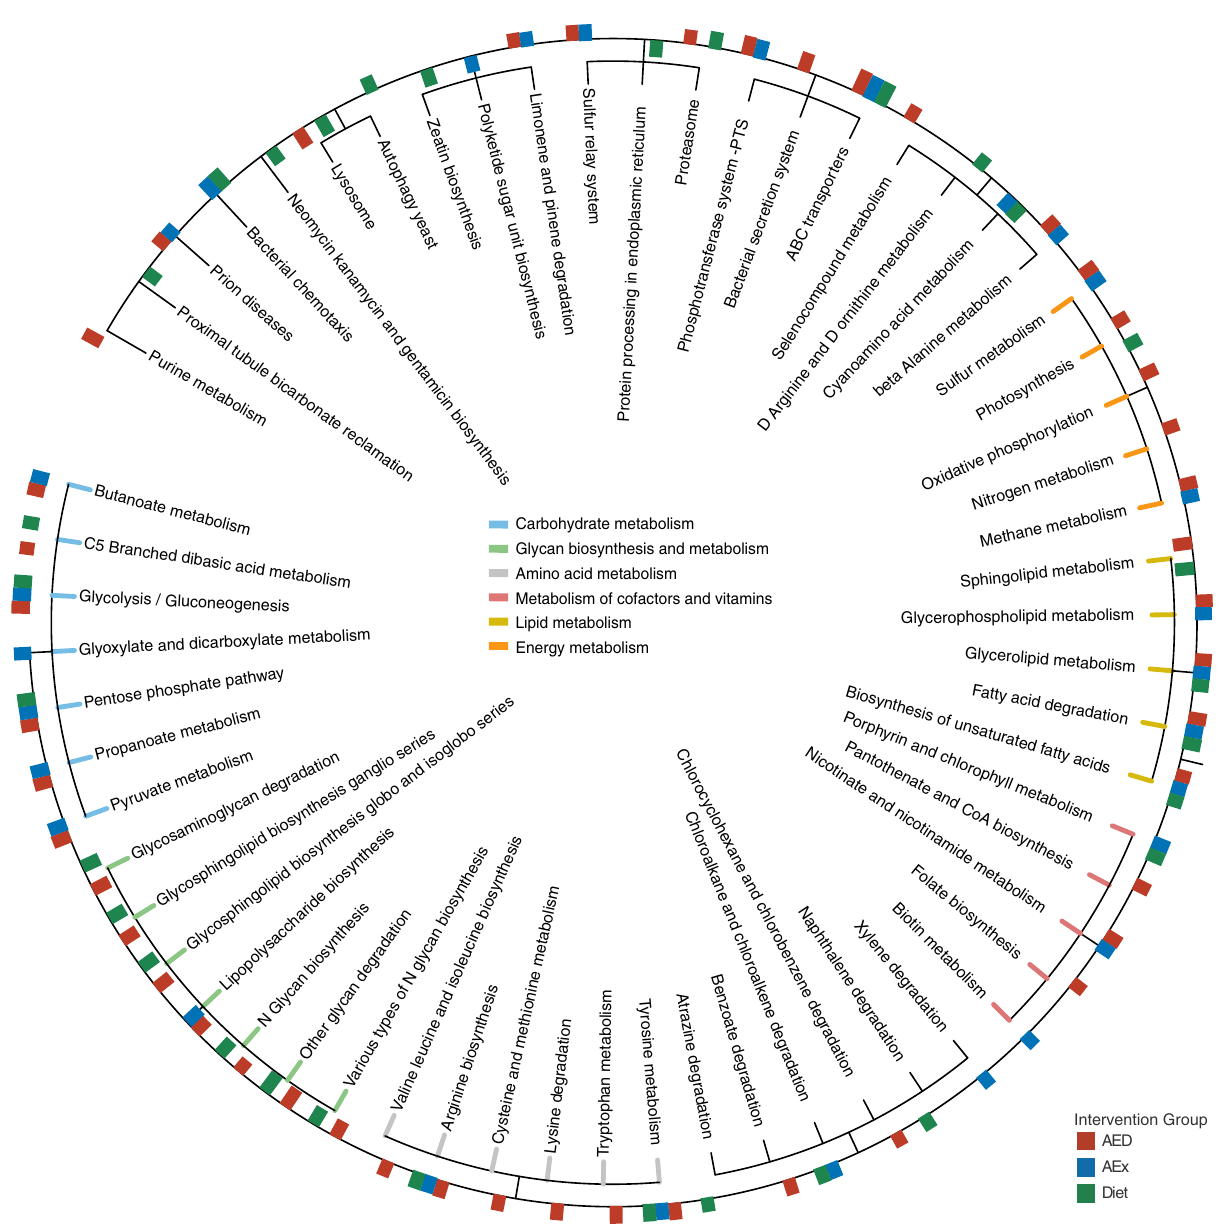
Fig. 3 Identi fi ed pathways by KEGG between intervention groups and NI group after intervention. Only signi fi cant pathways with a linear discriminate analysis (LDA) score > 2.0 and p < 0.05 are shown. Six colors indicate six primary function pathways. The bars inside the circle indicate that 3 intervention groups had higher values than the NI group, and the bars outside the circle indicate that the intervention groups had lower values than the NI group. The bar length represents LDA